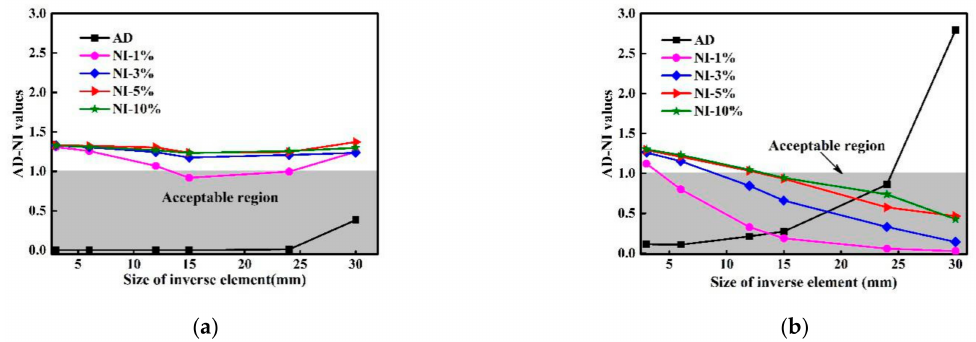
Figure 13. AD–NI curves for the ( a ) FEM-based and ( b ) iFEM-based damage identification